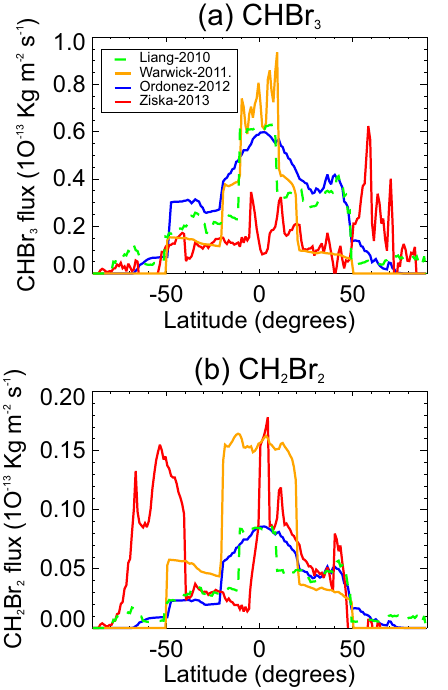
Fig. 3. Zonally averaged global emission source strength (10 − 13 kgm − 2 s − 1 ) for (a) CHBr 3 and (b) CH 2 Br 2 .